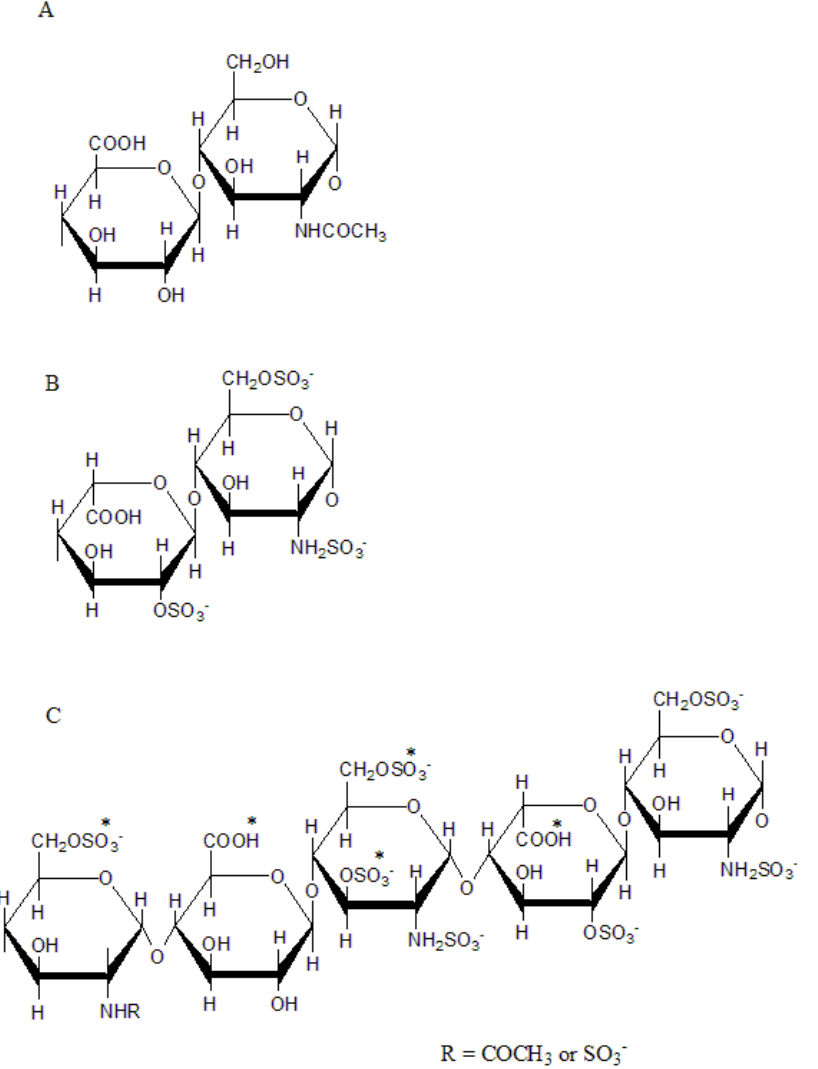
Fig. 1 – Structures in heparin and heparan sulfate. A) The precursor polysaccharide for both heparin and hep- aran sulfate, [-4)- β -D-GlcA-(1 → 4)- α -D-GlcNAc-(1-], which is also the predominant structure in heparan sulfate. Post-polymerization, enzymes 1) remove N -acetyl and replace with N -sulfate; 2) epimerize β -D- glucuronate residues at the reducing side of N -sulfate to α -L-iduronate; 3) introduce 2- O -sulfate and 4) intro- duce 6- O -sulfate (Kusche-Gullberg and Kjellen 2003). The final result of all these transformations is shown − − − in B) the main repeating unit of heparin [-4)- α -L-IdoA(2SO )-(1 → 4)- α -D-GlcNSO (6SO )-(1-]. Many 3 3 3 intermediate structures arise from incomplete action of the post-polymerization enzymes. C) The pentasac- − − − charide in heparin: [ 4)- α -D-GlcNAc(6SO )-(1 → 4)- α -D-GlcA-(1 → 4)- α -D-GlcNSO (3,6diSO )- 3 3 3 − − − (1 → 4)- α -L-IdoA(2SO )-(1 → 4)- α -D-GlcNSO (6SO )-(1-] which is the minimal structure with high 3 3 3 affinity for antithrombin, the serine protease in plasma which inhibits several coagulation enzymes. The substituents essential for this affinity are marked with an asterisk.